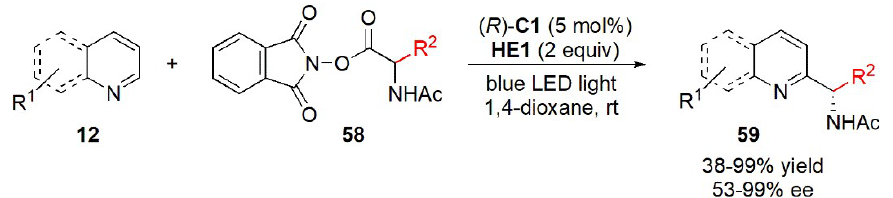
Figure 20. Enantioselective Minisci-type alkylation of N -heteroarenes by N -(acyloxy)phthalimide esters [92].